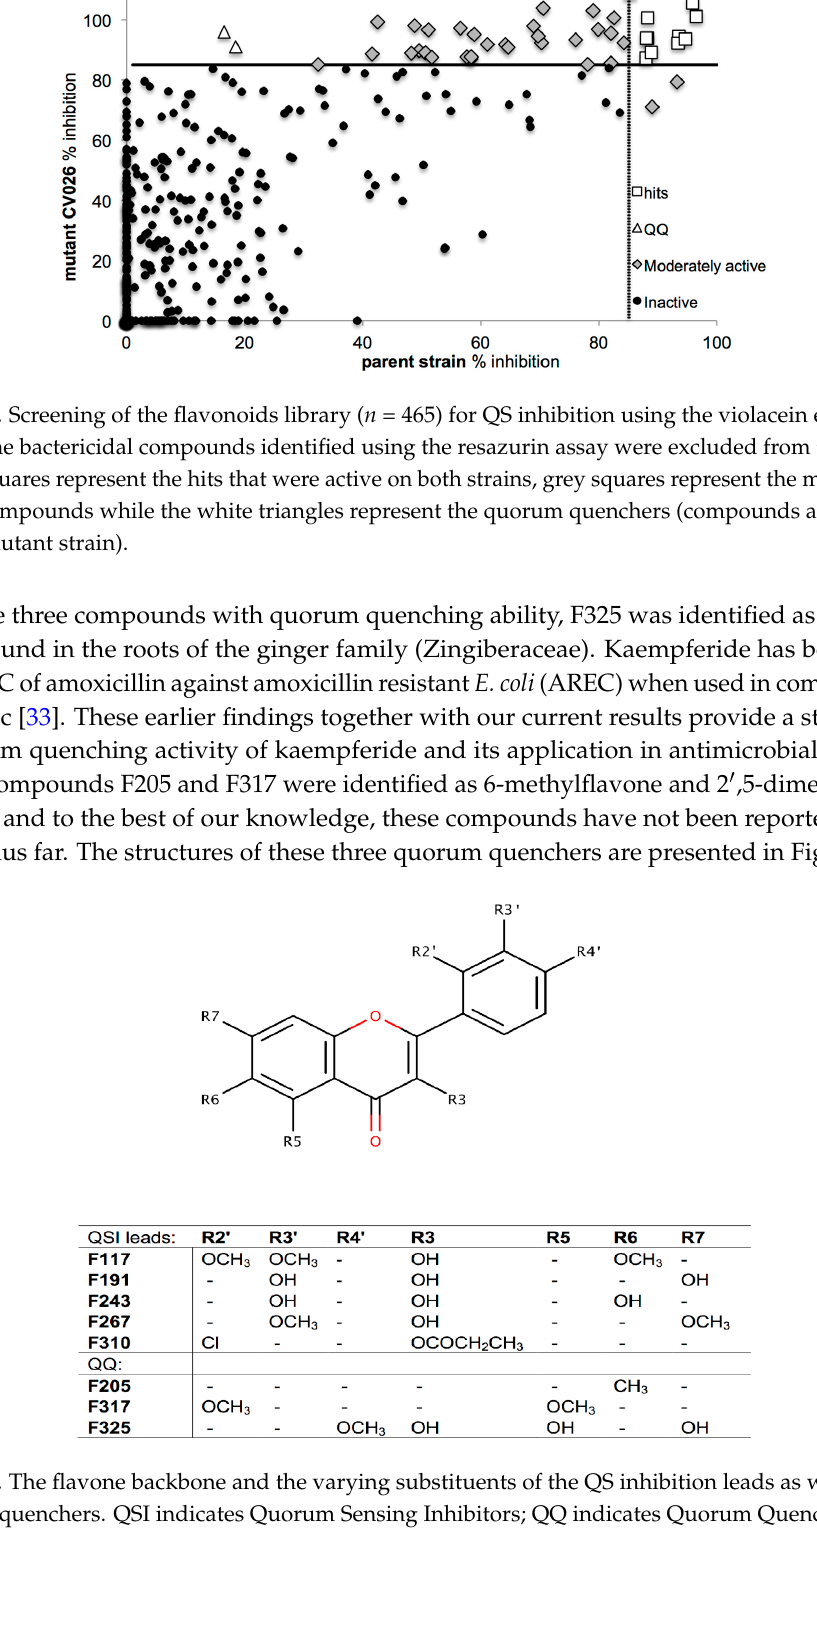
Figure 3. The flavone backbone and the varying substituents of the QS inhibition leads as well as the quorum quenchers. QSI indicates Quorum Sensing Inhibitors; QQ indicates Quorum Quenchers.